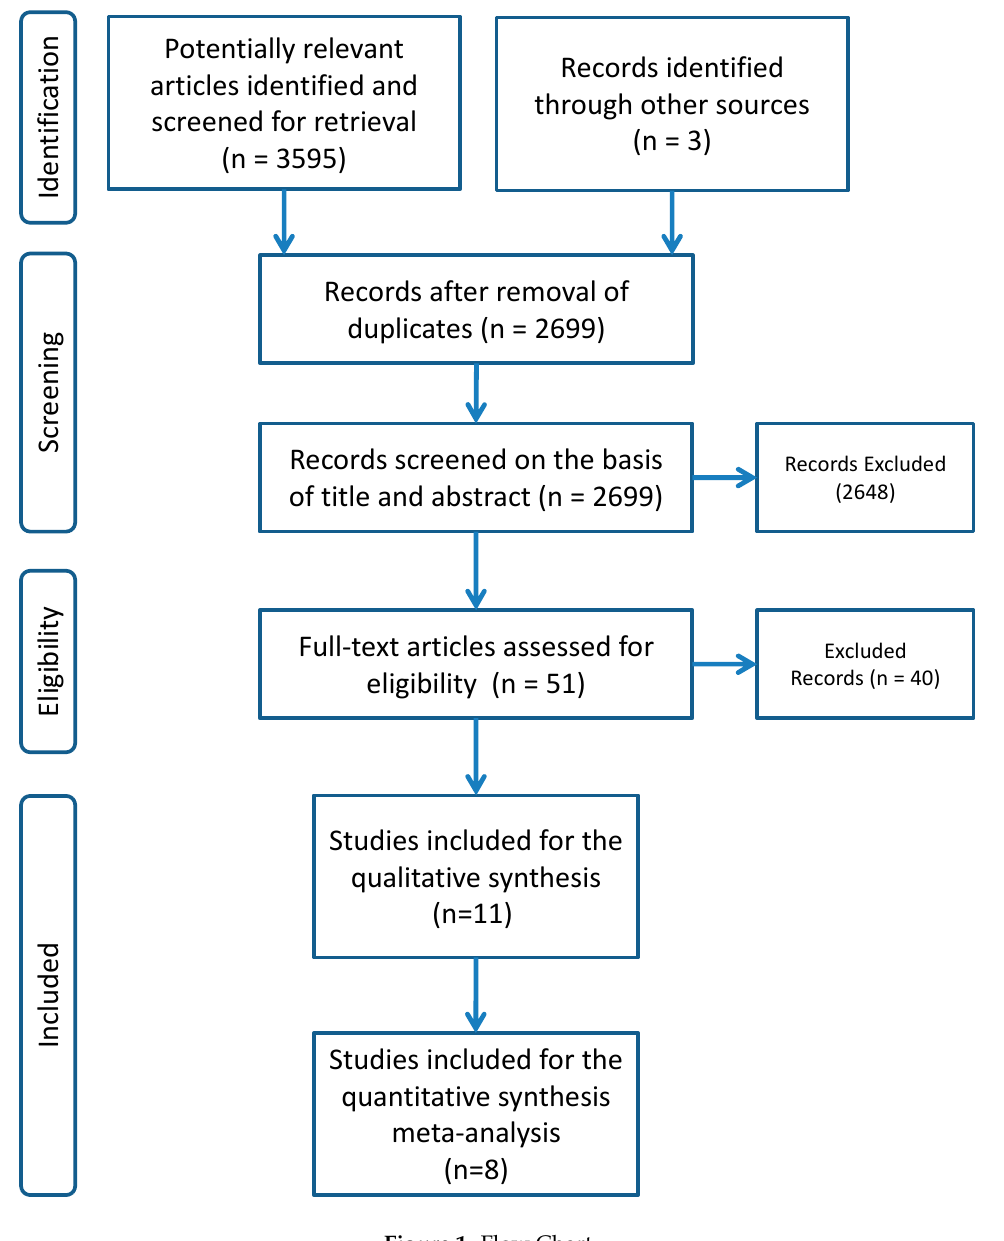
Figure 1. Flow Chart.